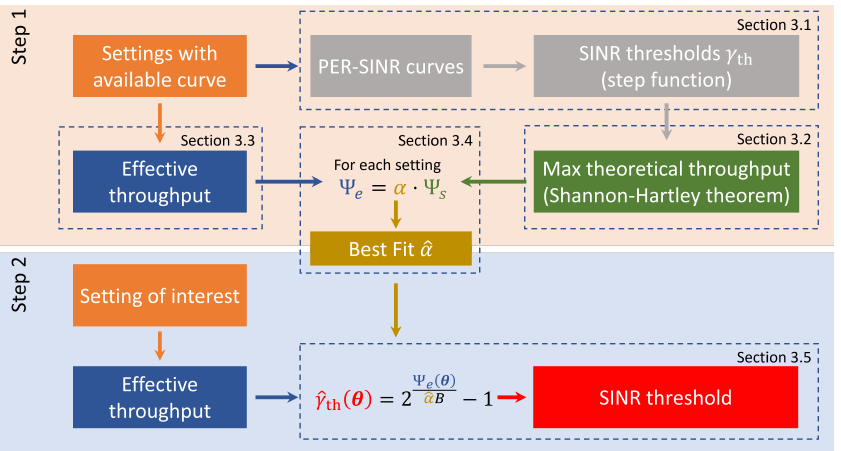
Figure 1. Illustration of the two main steps defining the proposed methodology for a given